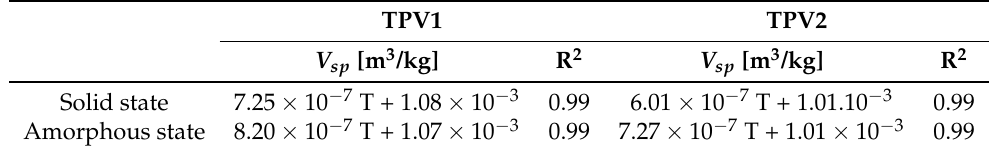
Table 6. Specific volume of TPVs under study.